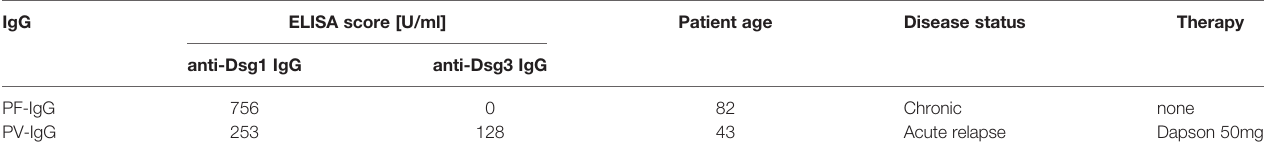
TABLE 1 | Clinical background of patient